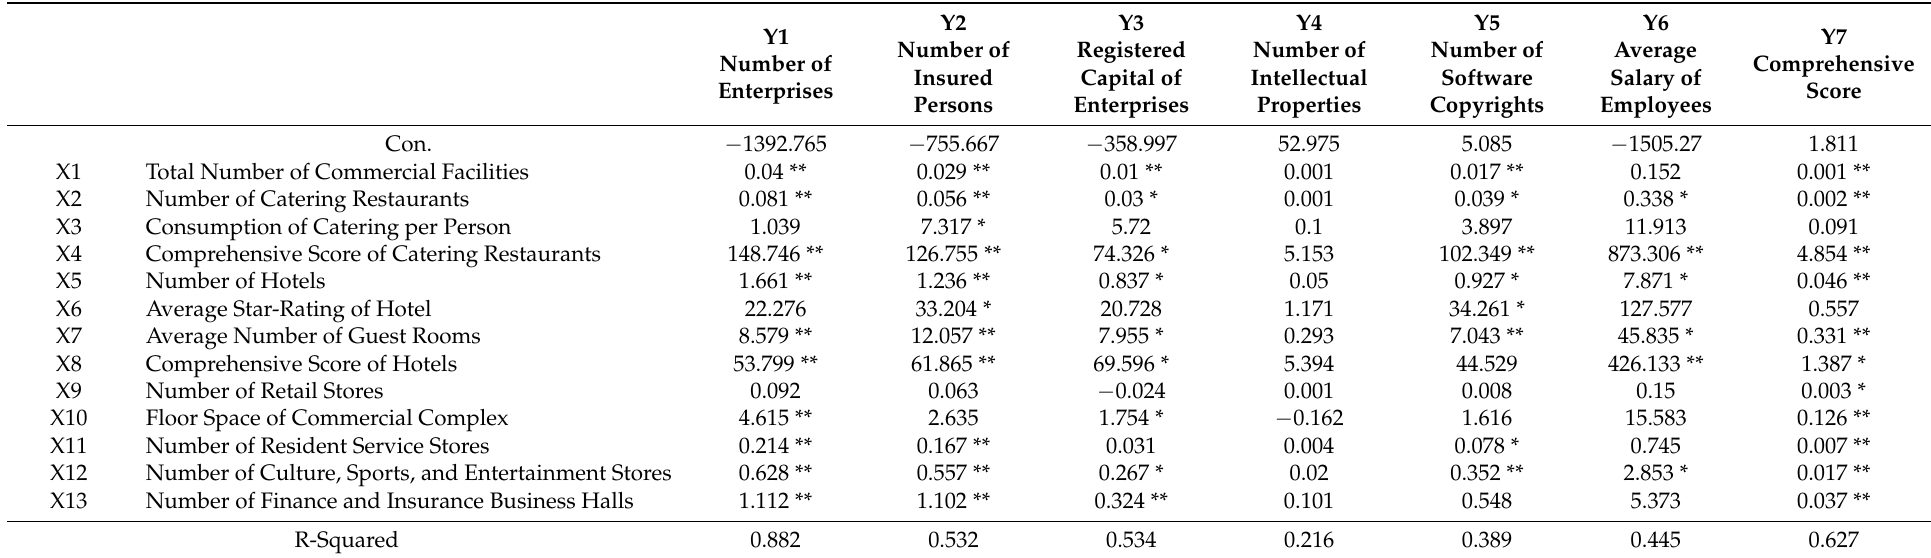
Table 8. Regression coefficients 1 and p -value 2 of